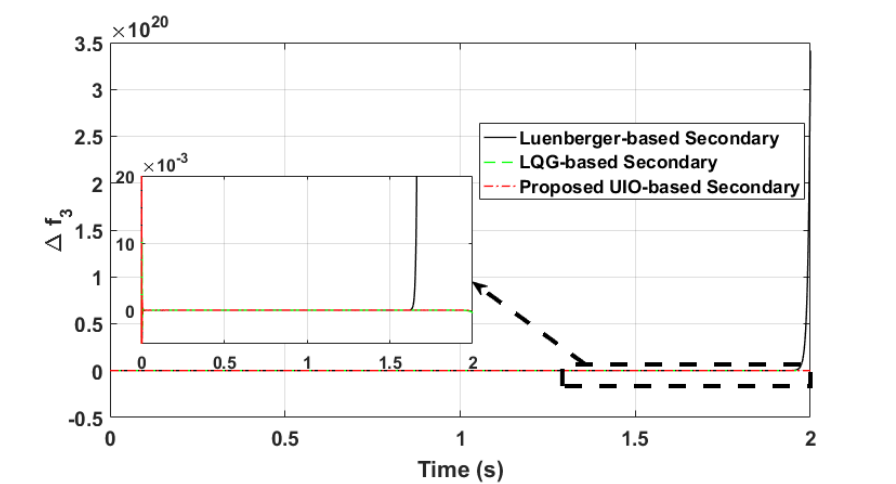
Figure 17. Third inverter frequency dynamic ∆ f 3 in scenario 3 (Stealthy FDI to second inverter’s ac-